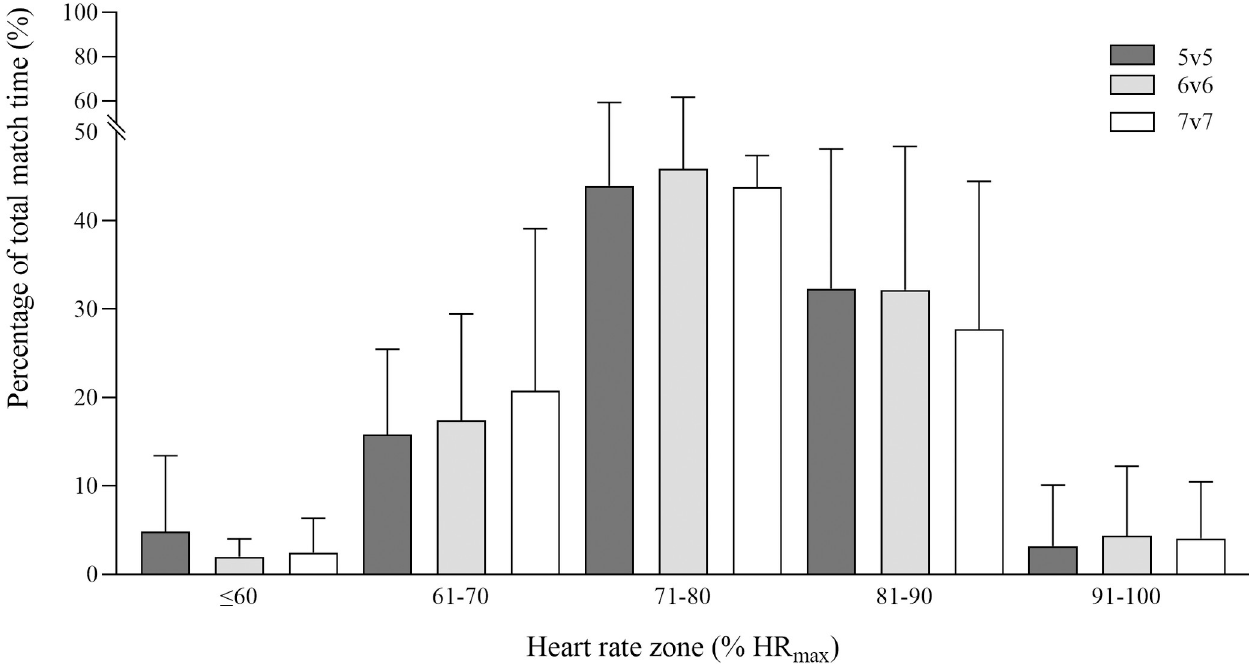
Fig 2. Percentage of total match time spent in each intensity zone expressed as percentage of players’ maximal heart rate (HR max ) during 5v5 (dark grey bars), 6v6 (light grey bars) and 7v7 (white bars) recreational team handball game formats (data are presented as means ± SD).